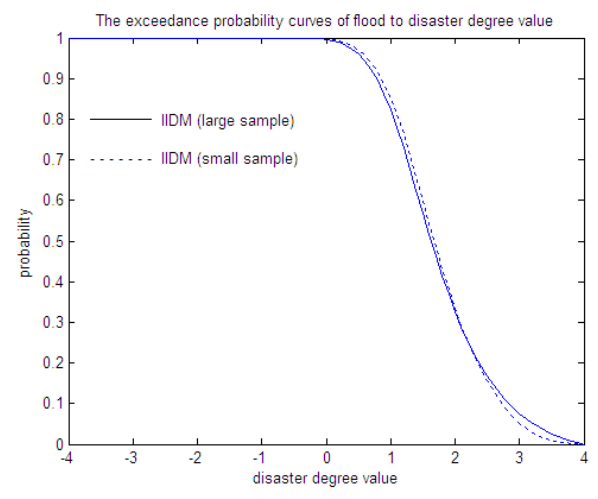
686 Fig. 4 comparison of the risks by IIDM with the small sample and the large sample 687 Fig. 4. Comparison of the risks by IIDM with the small sample and the large sample.